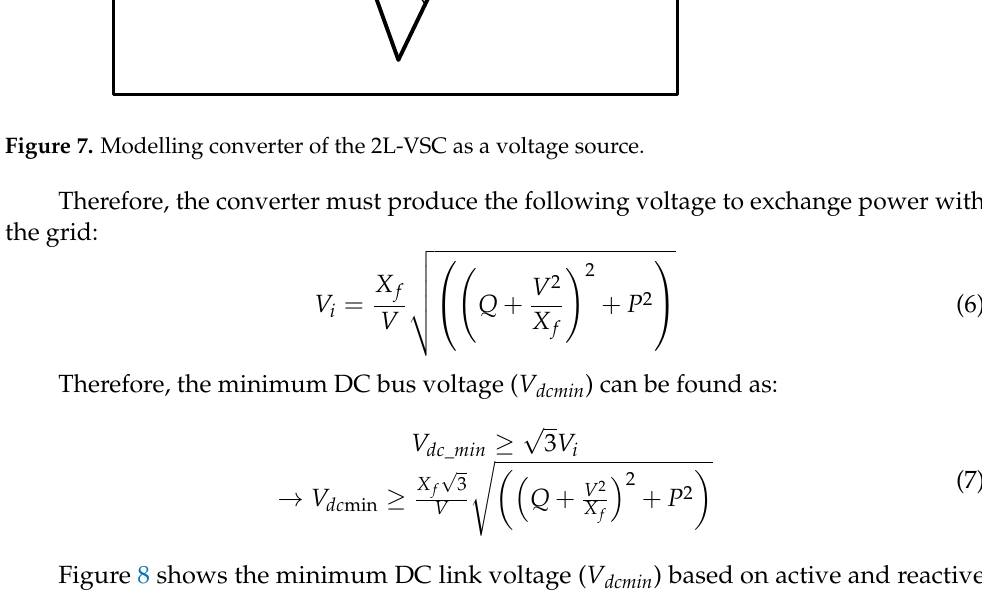
Figure 7. Modelling converter of the 2L-VSC as a voltage source.